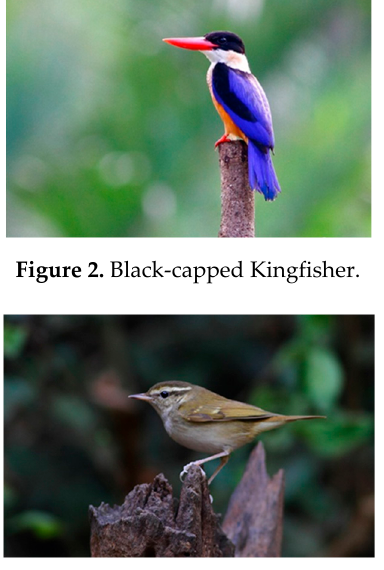
Figure 3. Yellow-browed Leaf Warbler.